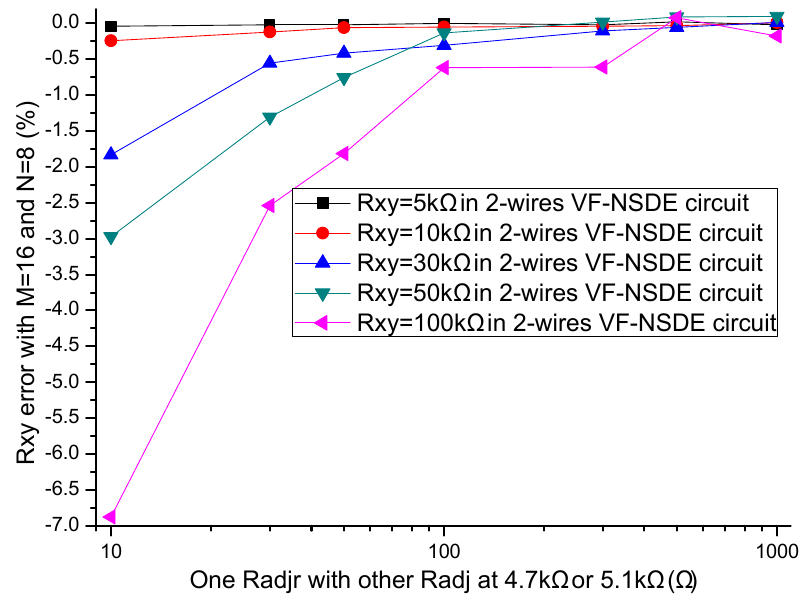
Figure 10. The R adjr effect on R xy errors in the two-wire VF-NSDE prototype circuit.